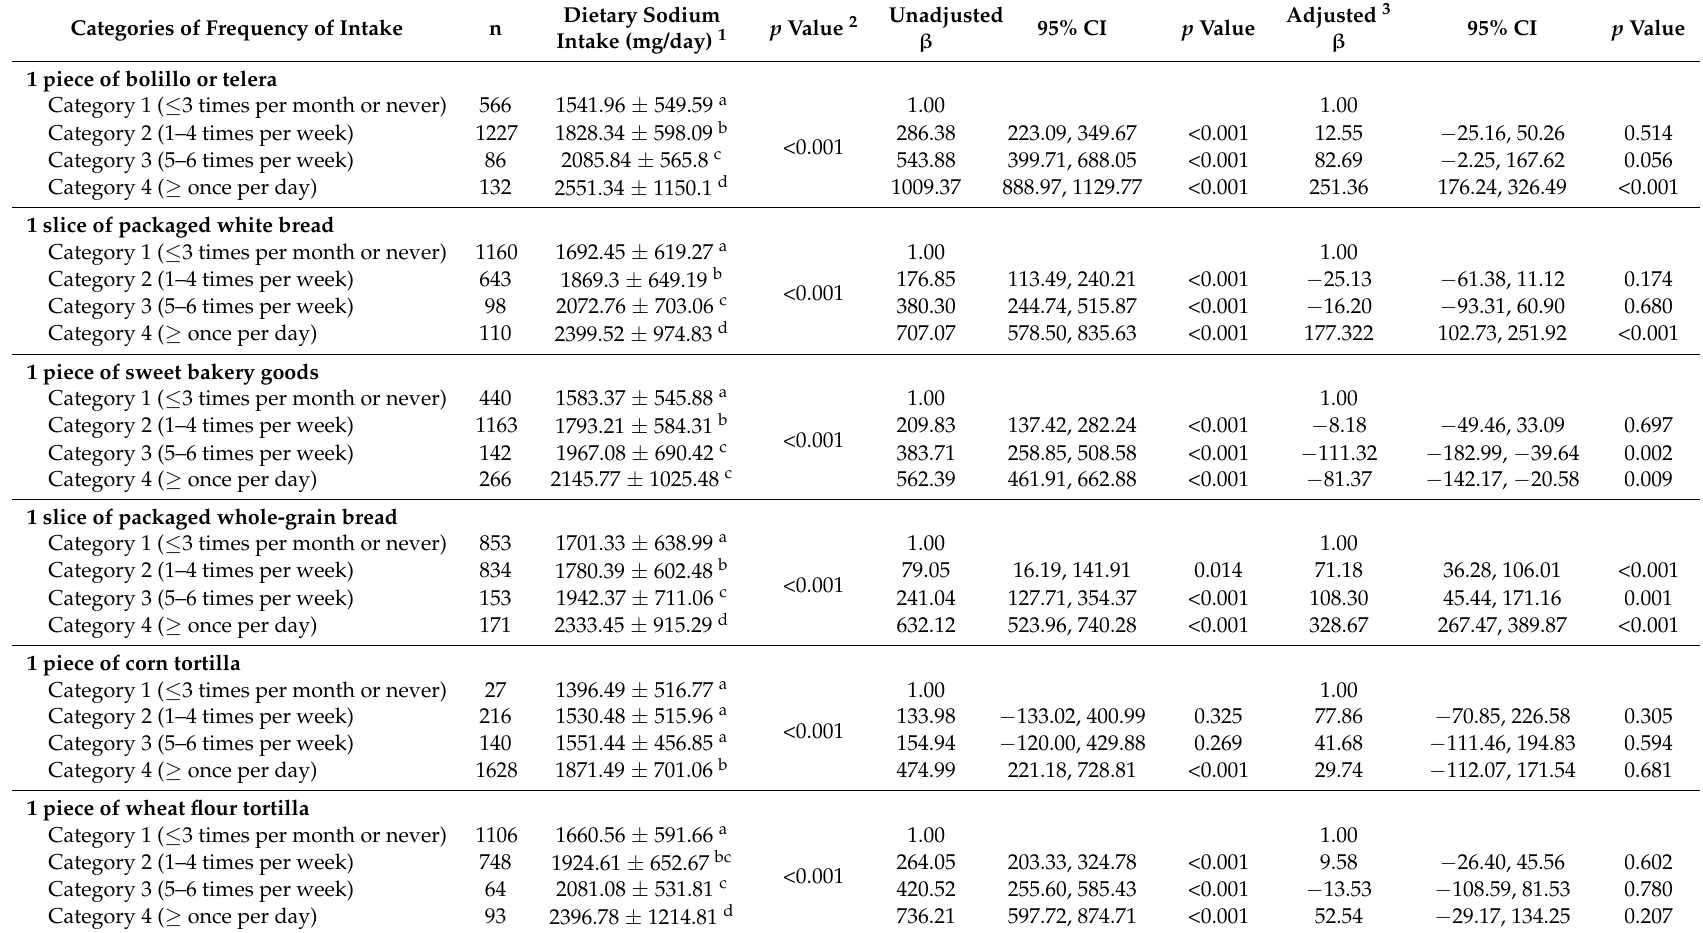
Table 3. Mean daily sodium intake (mg/day) across categories of frequency of intake and linear regression analysis for the association between categories of frequency of intake of food products and daily sodium intake